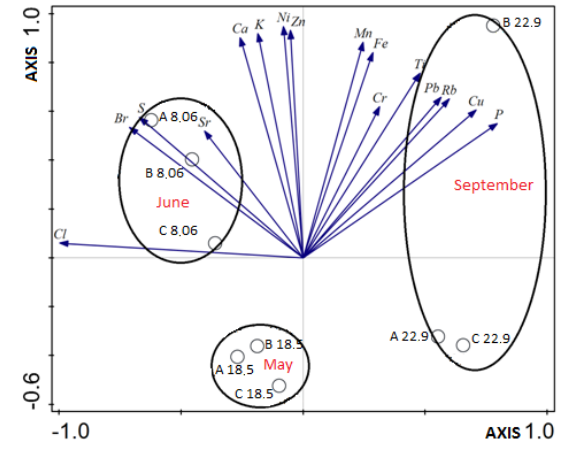
Figure 3: Principal components analysis (PCA), changes in the content of elements in studied water biotopes in the month (May, June and September).